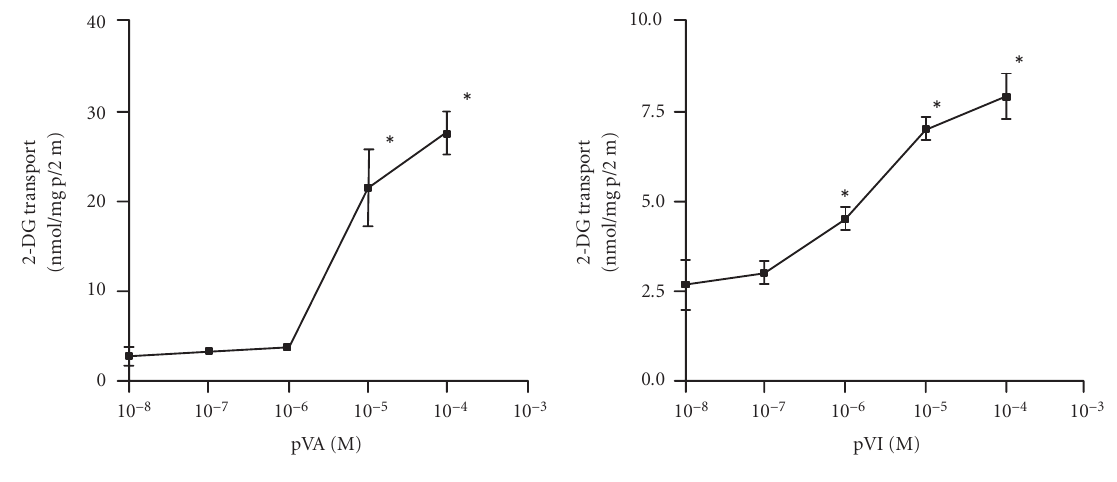
(c) E ff ect of pVA on 2-DG transport in human fibroblasts. (d) E ff ect of pVI on 2-DG transport in human fibroblasts. Figure 1. E ff ect of di ff erent vanadate compounds at several concentrations on basal and insulin-stimulated 2-DG transport in human fibroblasts. Panel (a) sodium orthovanadate; no significant di ff erences were seen, P > . 05, 1-way ANOVA, F = 2 . 983, n = 4 (triplicate plates in all experiments). Panel (b) pervanadate; P < . 05, 1-way ANOVA, F = 13 . 1, n = 3 (triplicate plate in all experiments). Panel (c) pVA; ∗ P < . 05, 1-way ANOVA, F = 157 . 9, n = 3